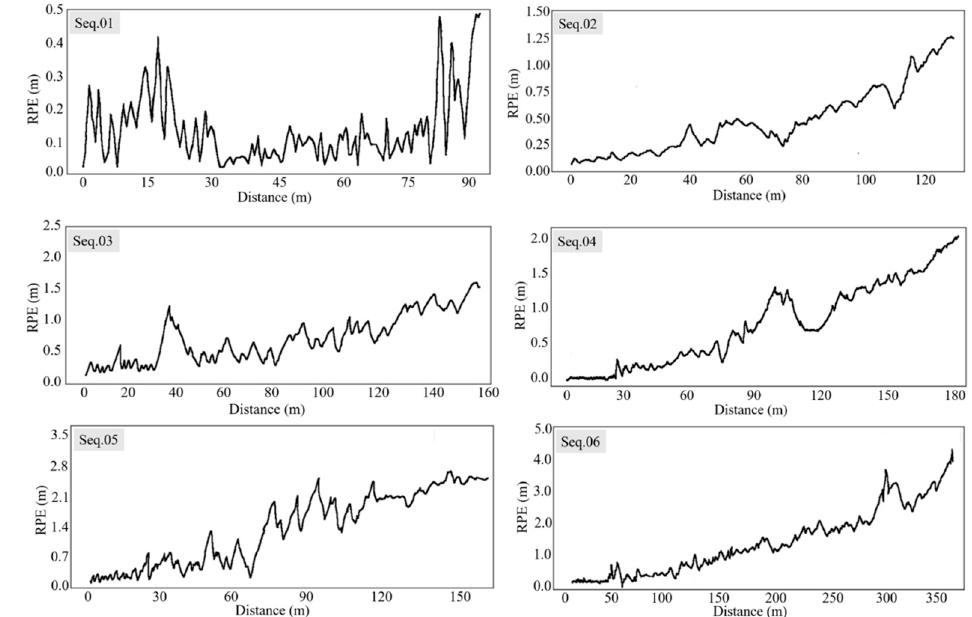
Figure 7. Relative Pose Error in 6 sequences.